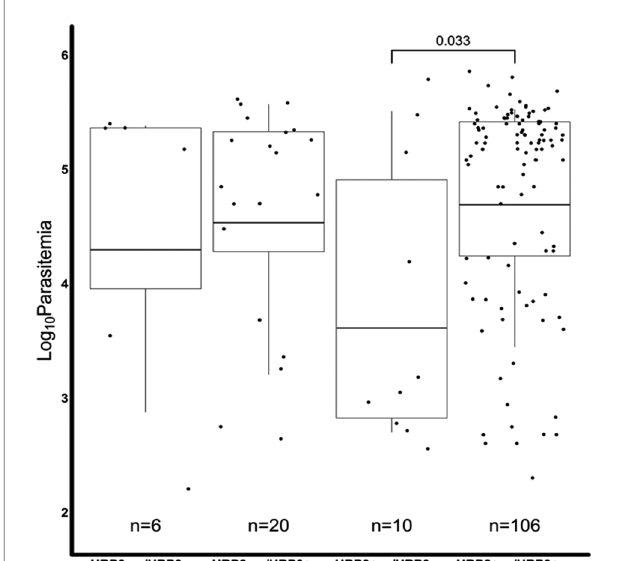
FIGURE 2 A comparison of the microscopy log base 10 parasitemia of the Pfhrp2/3 genotypes. The log 10 geometric mean of the Pfhrp2/3 genotypes was, 4.30 (32,212 parasites/µl), 4.53 (44,247 parasites/µl), 3.61